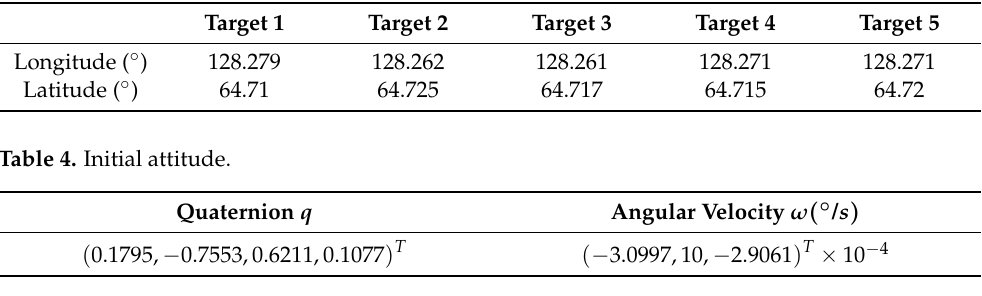
Table 3. Locations of ground targets.